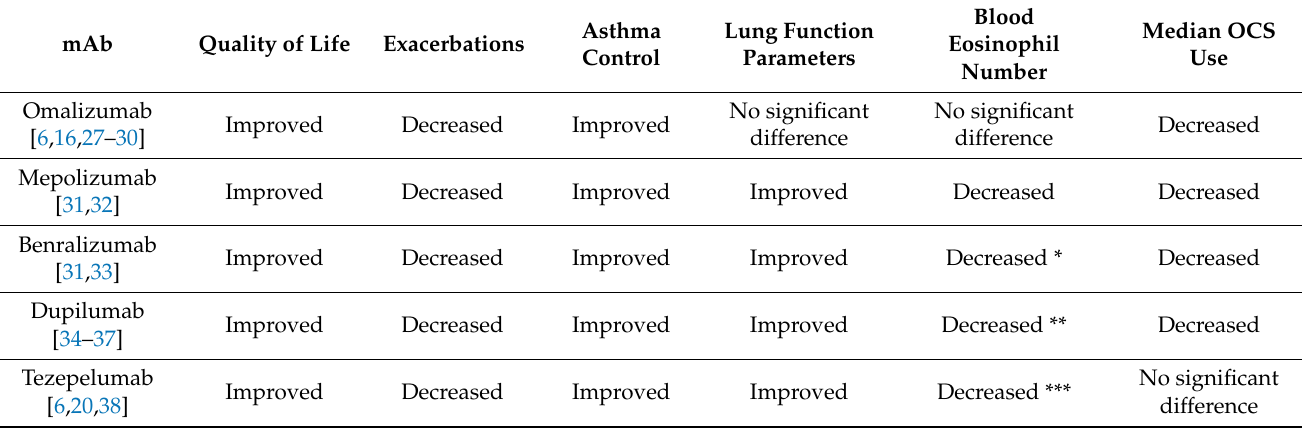
Table 2. Clinical Outcomes: comparison among monoclonal